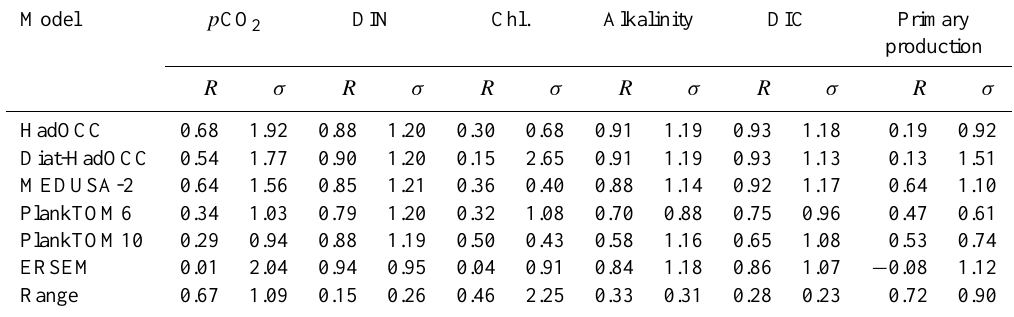
Table 3. Model–observation correlation coefficients ( R) and standard deviations normalised by the standard deviation of observations ( σ) for all examined annual surface fields and depth-integrated primary productivity. Model p CO 2 DIN Chl. Alkalinity DIC Primary